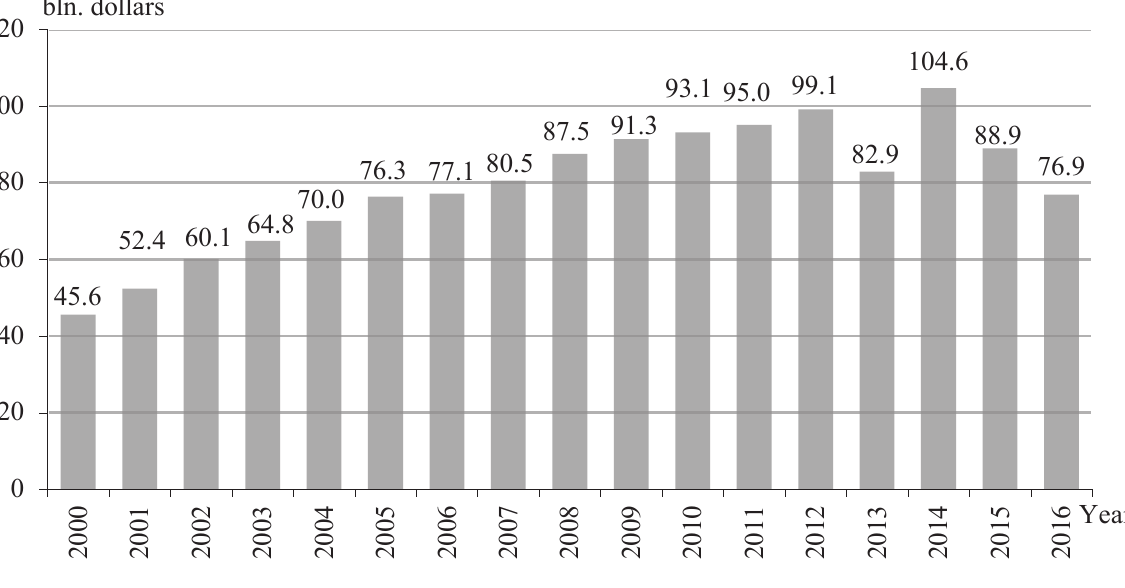
Figure 1. The market of outsourcing services in the world in the period 2000–2016 The following chart shows that revenues from out- sourcing were steadily growing, but in 2013 we see a decline in the volume of such services to 82.9 bil- lion US dollars. The market recovered in the fol- lowing year, reaching 104.6 billion US dollars, but then fell again in 2016 to 76.9 billion dollars. The largest share of these services belongs to Europe, Middle East, Africa and the North America. A much smaller share belongs to the Asian-Pacific